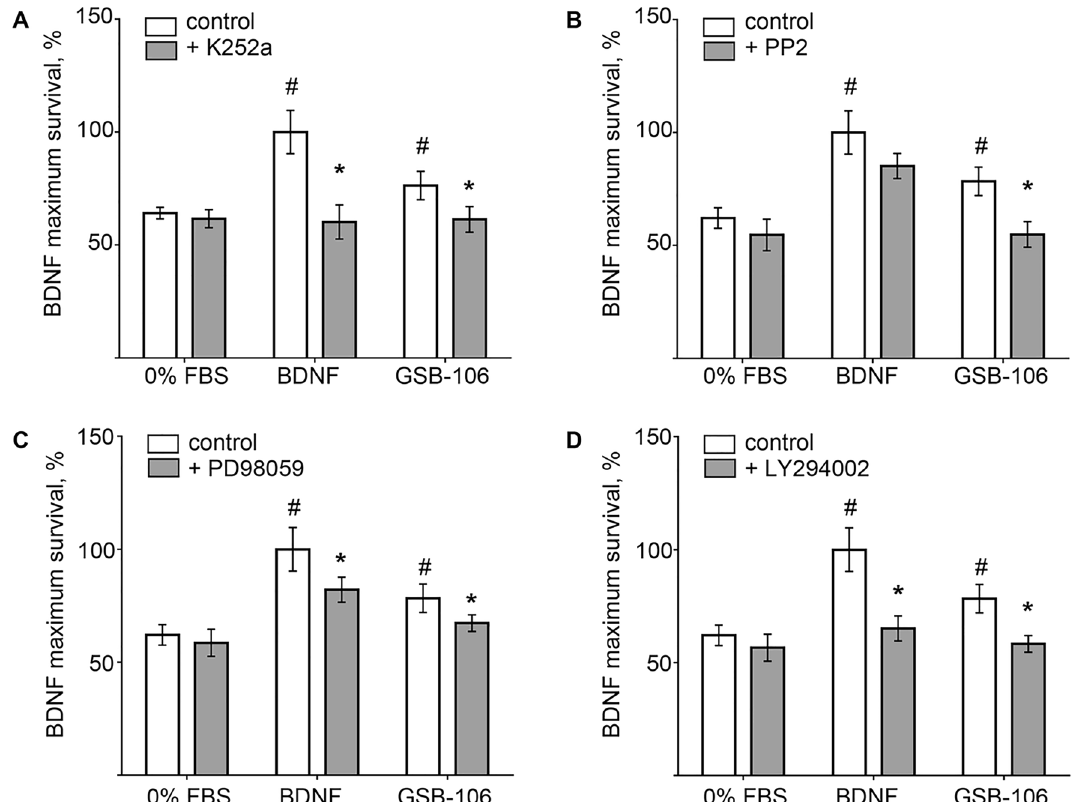
Figure 2. GSB-106 promotes survival of serum-deprived SH-SY5Y cells through TrkB and downstream signaling pathways. ( A ) Survival analysis of serum-deprived SH-SY5Y cells (2 × 10 5 /well) incubated with BDNF (1 nmol), GSB-106 (100 nmol) in the presence of K252a (500 nmol) for 48 h. Cell viability was normalized to viability in BDNF group (n = 5; # p < 0.05 in relation to 0% FBS-control; *p < 0.05; in relation to agonist without inhibitor; Wilcoxon t -test). ( B ) Survival analysis of serum-deprived SH-SY5Y cells (2 × 10 5 /well) incubated with BDNF (1 nmol), GSB-106 (100 nmol) in the presence of PP2 (100 μmol) for 48 h. Cell viability was normalized to viability in BDNF group (n = 5; # p < 0.05 in relation to 0% FBS-control; *p < 0.05; in relation to agonist without inhibitor; Wilcoxon t -test). ( C ) Survival analysis of serum-deprived SH-SY5Y cells (2 × 10 5 /well) incubated with BDNF (1 nmol), GSB-106 (100 nmol) in the presence of PD98059 (50 μmol) for 48 h. Cell viability was normalized to viability in BDNF group (n = 5; # p < 0.05 in relation to 0% FBS-control; *p < 0.05; in relation to agonist without inhibitor; Wilcoxon t -test). ( D ) Survival analysis of serum-deprived SH-SY5Y cells (2 × 10 5 / well) incubated with BDNF (1 nmol), GSB-106 (100 nmol) in the presence of LY294002 (1 μmol) for 48 h. Cell viability was normalized to viability in BDNF group (n = 5; # p < 0.05 in relation to 0% FBS-control; *p < 0.05; in relation to agonist without inhibitor; Wilcoxon t